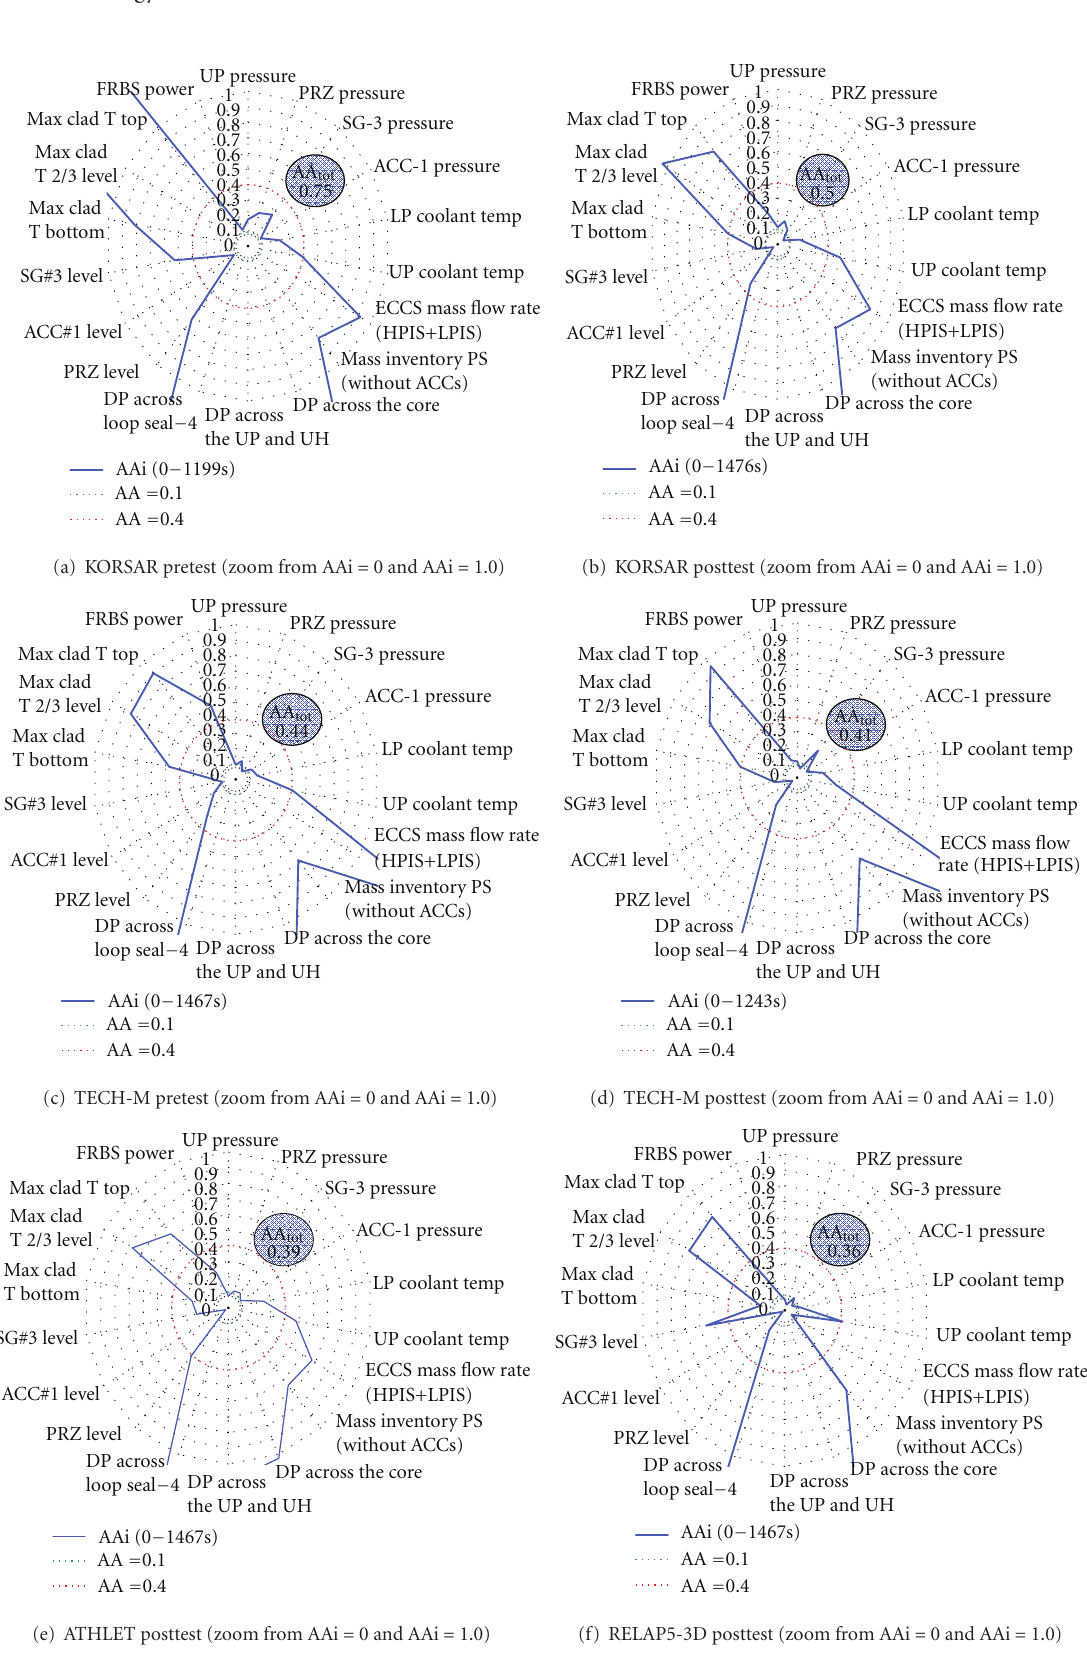
Figure 6: FFTBM application: quantitative accuracy evaluation of the results (overall